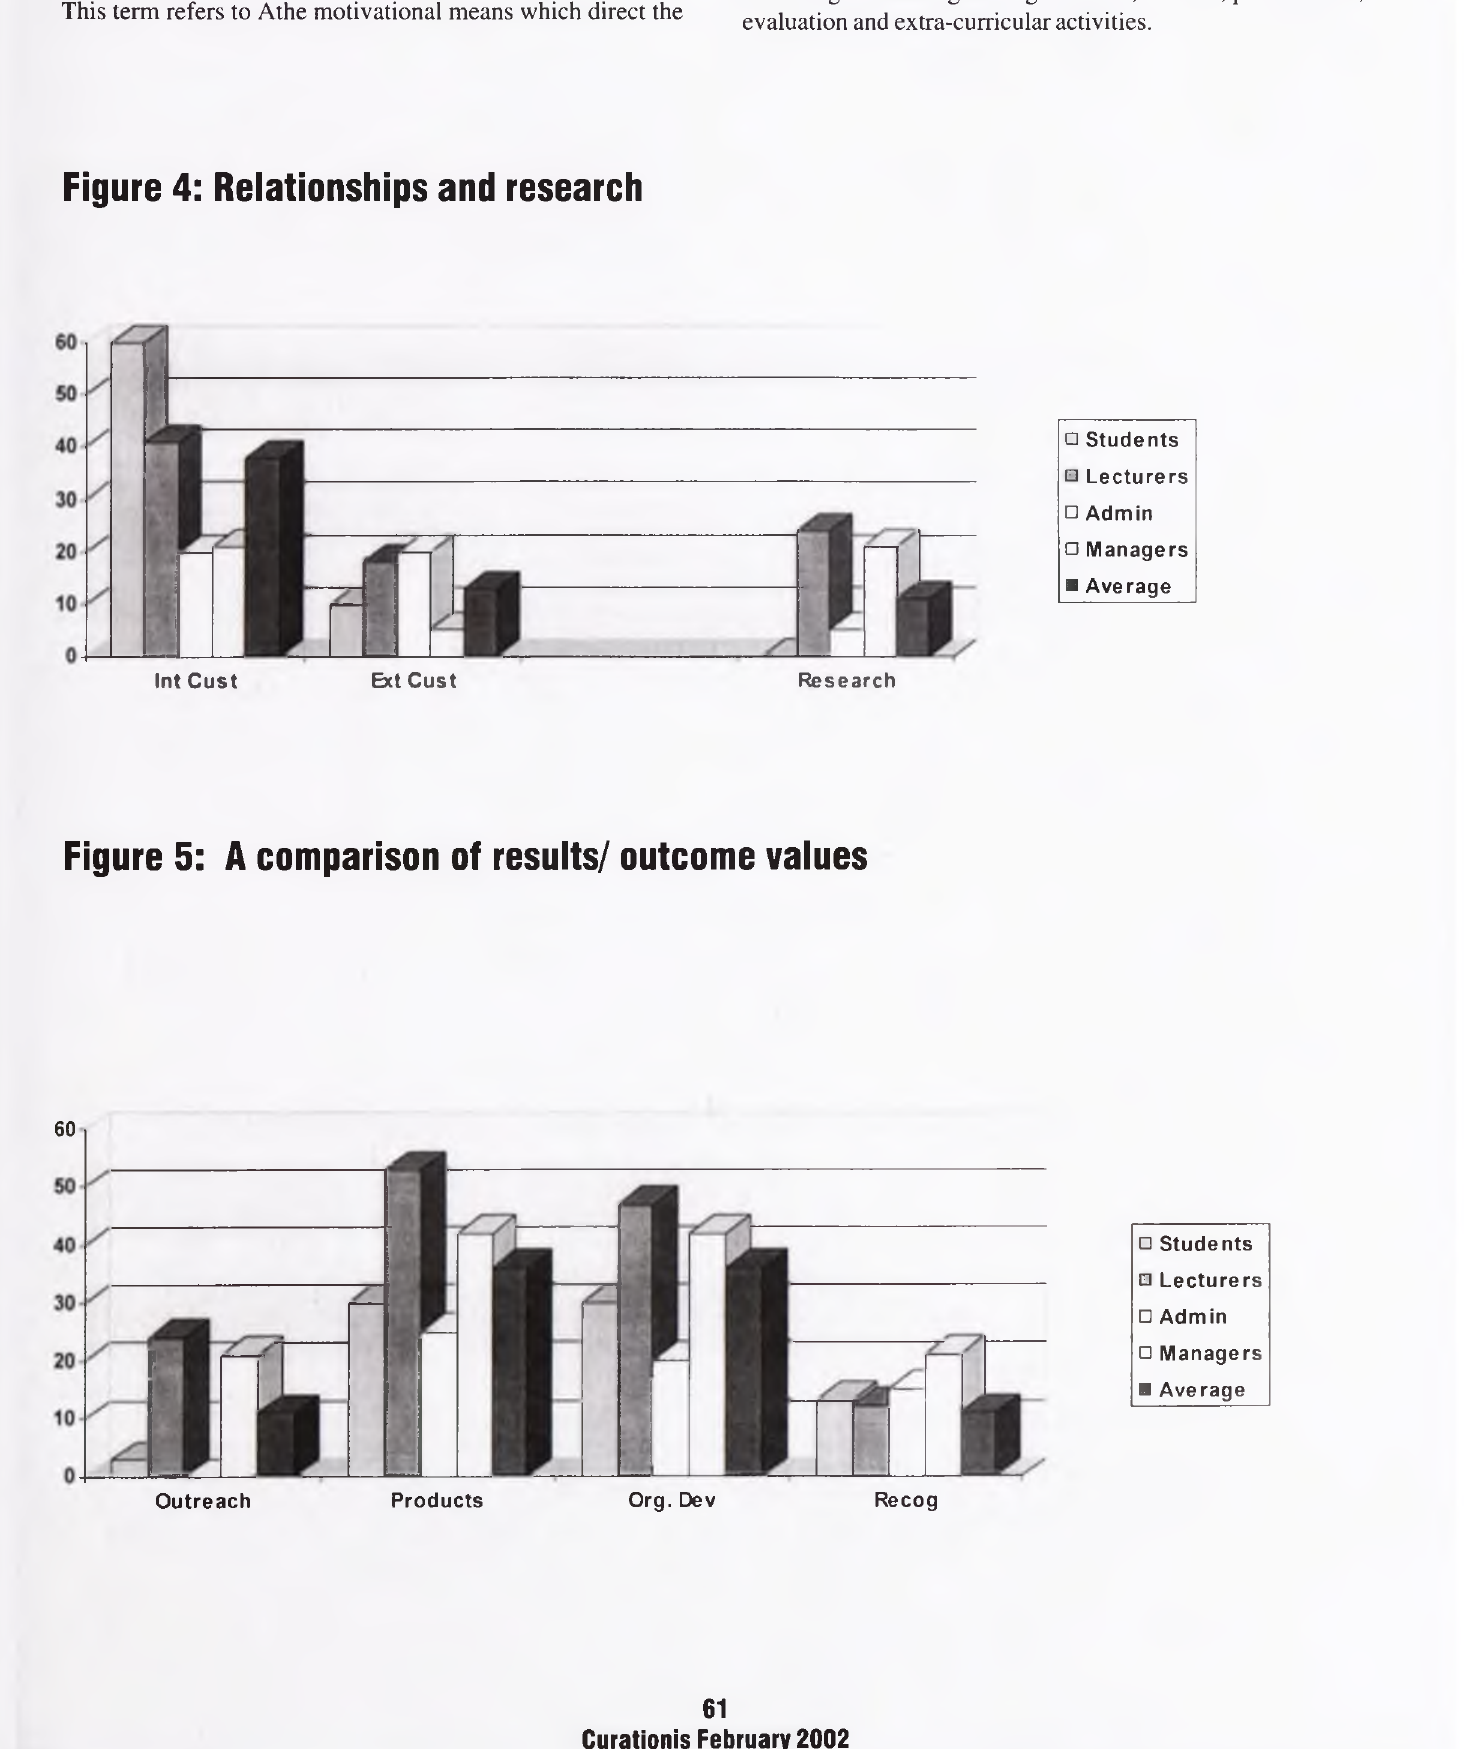
Figure 4: Relationships and research